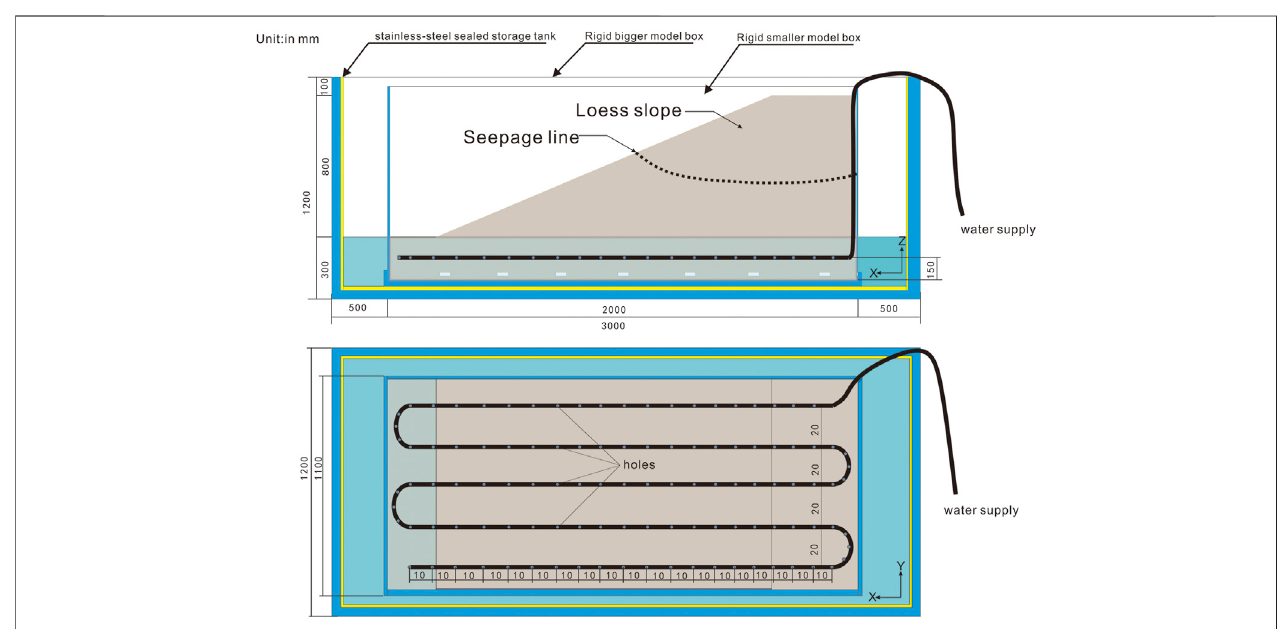
FIGURE 2 | The fi nal loess slope